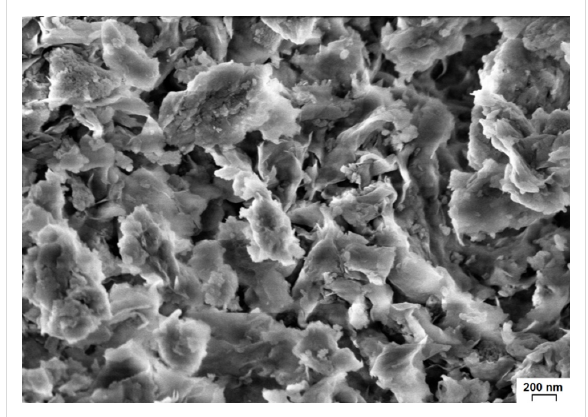
Figure 13: SEM image of the surface of original MM.